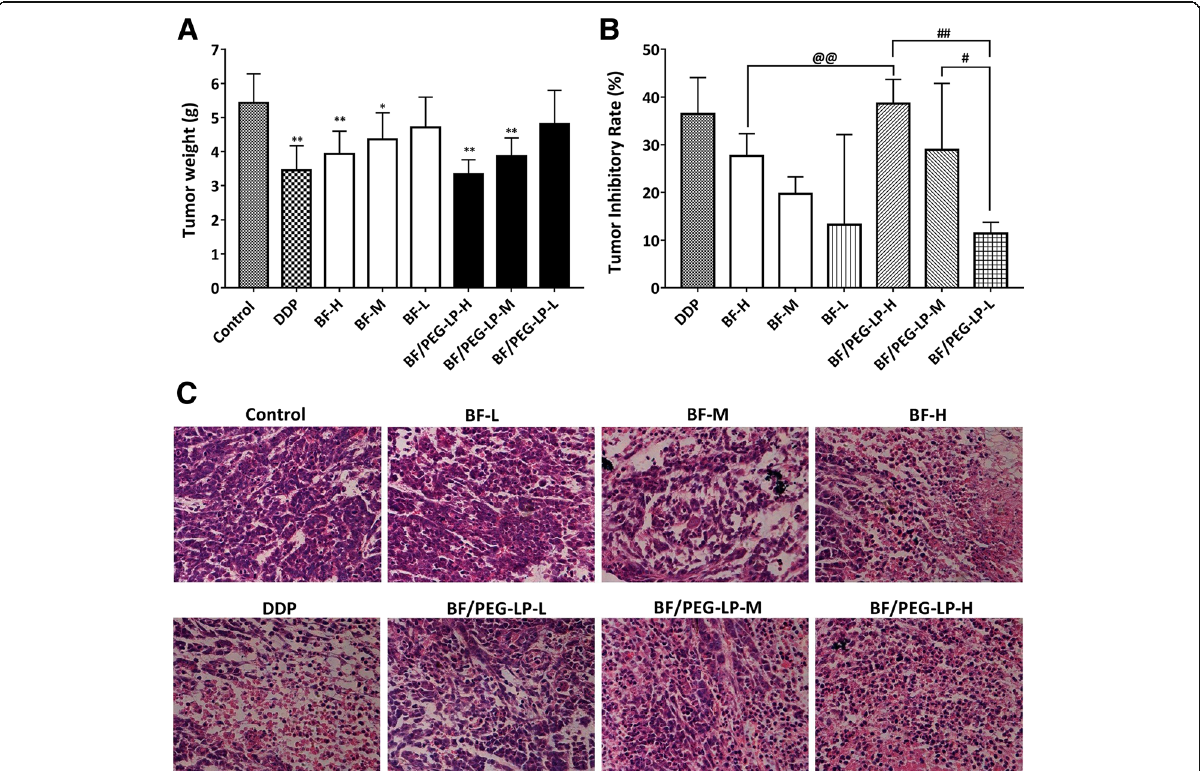
Fig. 4 Inhibitory effect of BF and BF/PEG-LP on the growth of glioma xenografts in nude mice. Comparison of the tumor weight ( a ) and tumor inhibition rate ( b ) in each group. Data are presented as (cid:2) x ± s ( n = 10). *P < 0.05, **P < 0.01 vs. control group; # P < 0.05, ## P < 0.01 vs . high-dose BF/ PEG-LP group. c H&E staining of tumor tissues from tumor-bearing mice. Abbreviations: BF, bufalin; BF/PEG-LP, bufalin-loaded PEGylated liposomes; DPP, cisplatin; H&E, hematoxylin and